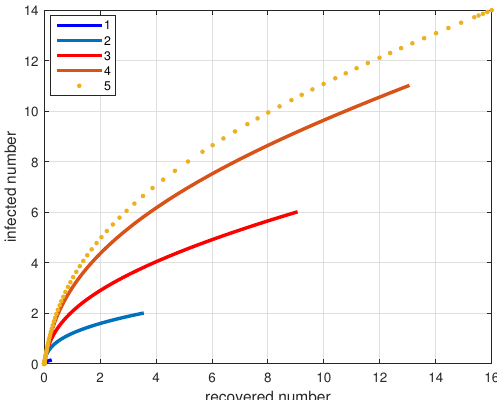
Figure 6. The phase portraits of I vs. R for system (1). The five trajectories correspond to different initial conditions and R 0 = 0.1087 < 1.